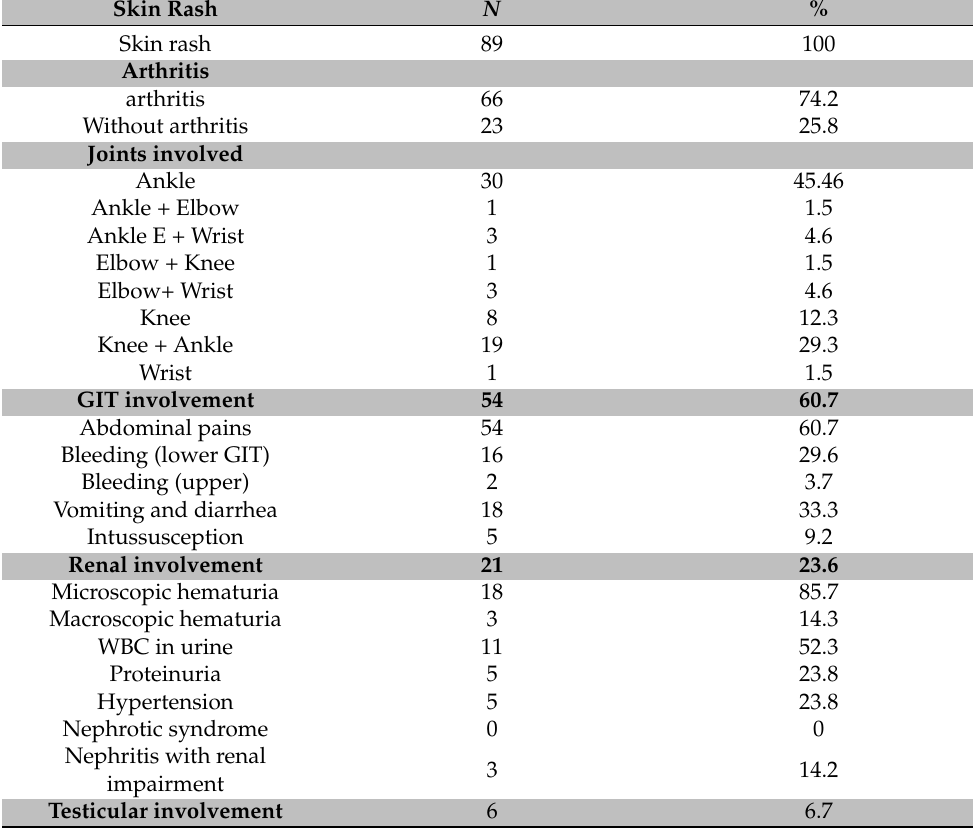
Table 2. Clinical features in 89 children with IgA vasculitis.